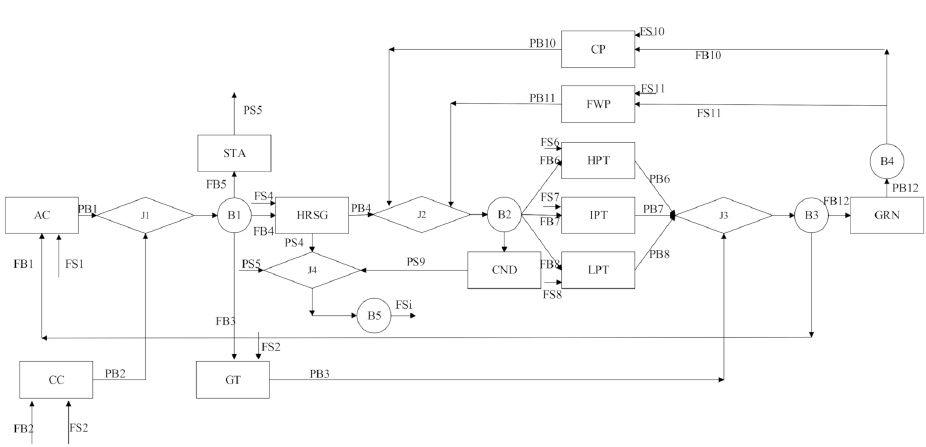
Figure 3. Productive structure of CCGT